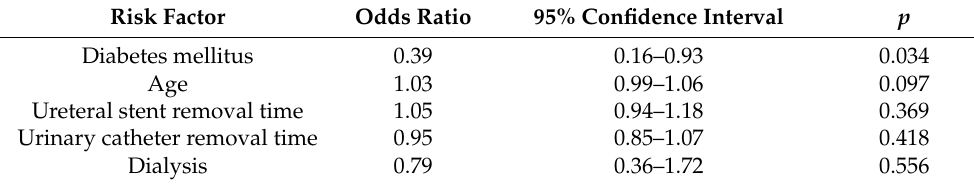
Table 3. Multivariate analysis for urinary tract infection after kidney